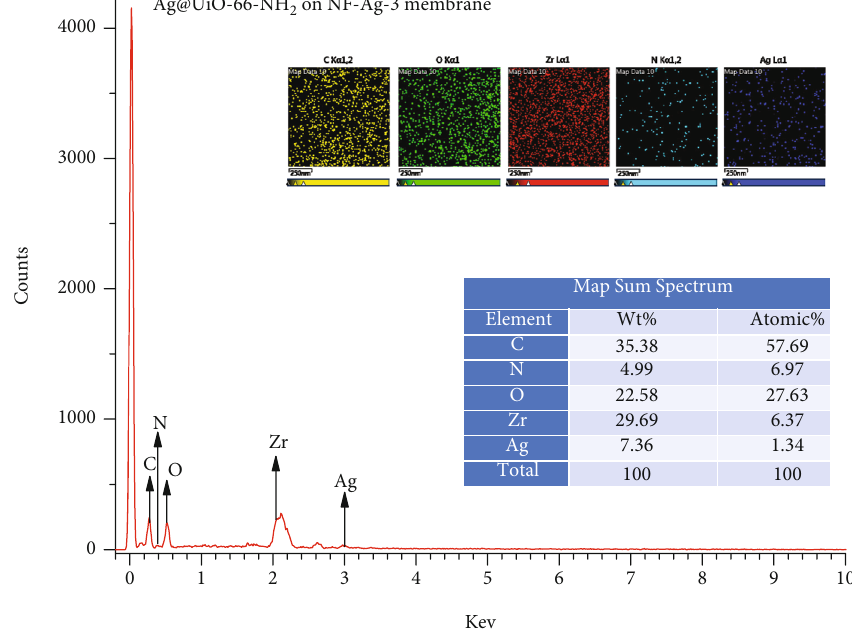
Figure 8: EDS mapping of Ag@UiO-66-NH